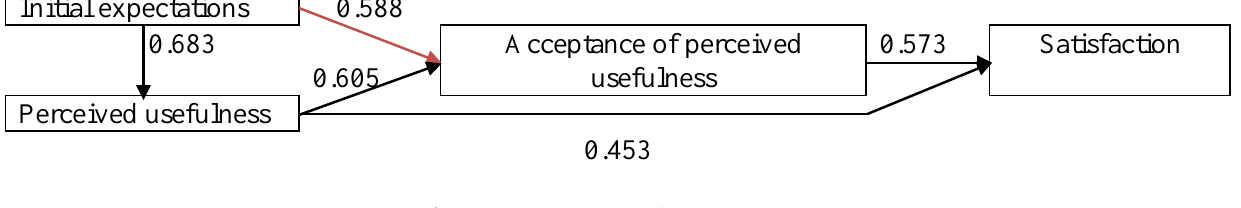
Fig. 2. The results of path analysis